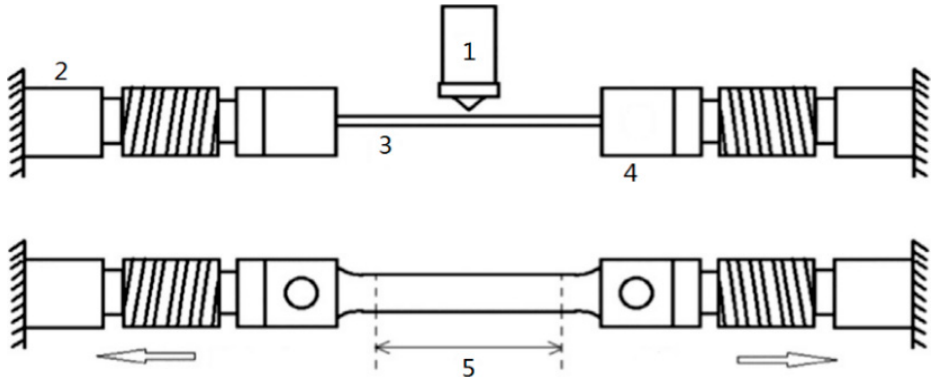
Figure 3. Diagrammatic sketch of in situ tensile test platform. 1, Metallurgical microscope and charge ‐ coupled device (CCD) Image capture card; 2, In situ test machine; 3, DP800 sample; 4, Fixture; 5, Gauge.